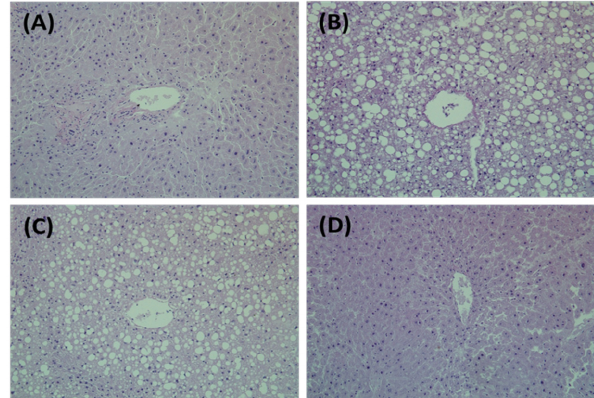
Figure 1. Effects of Platycodon grandiflorum (PG) extracts on Hepatic Morphology in a High ‐ fat Diet ‐ fed C57BL ‐ 6J. ( A ) ND, normal diet; ( B ) HFD, high ‐ fat diet; ( C ) HPGL, high ‐ fat diet with 1% P. grandiflorum ; ( D ) HPGH, high ‐ fat diet with 5% P. grandiflorum . Liver tissues were stained with hematoxylin